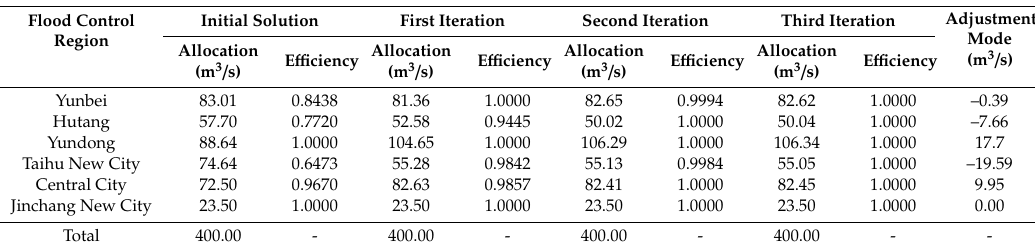
Table 4. Allocations and e ffi ciencies of flood drainage